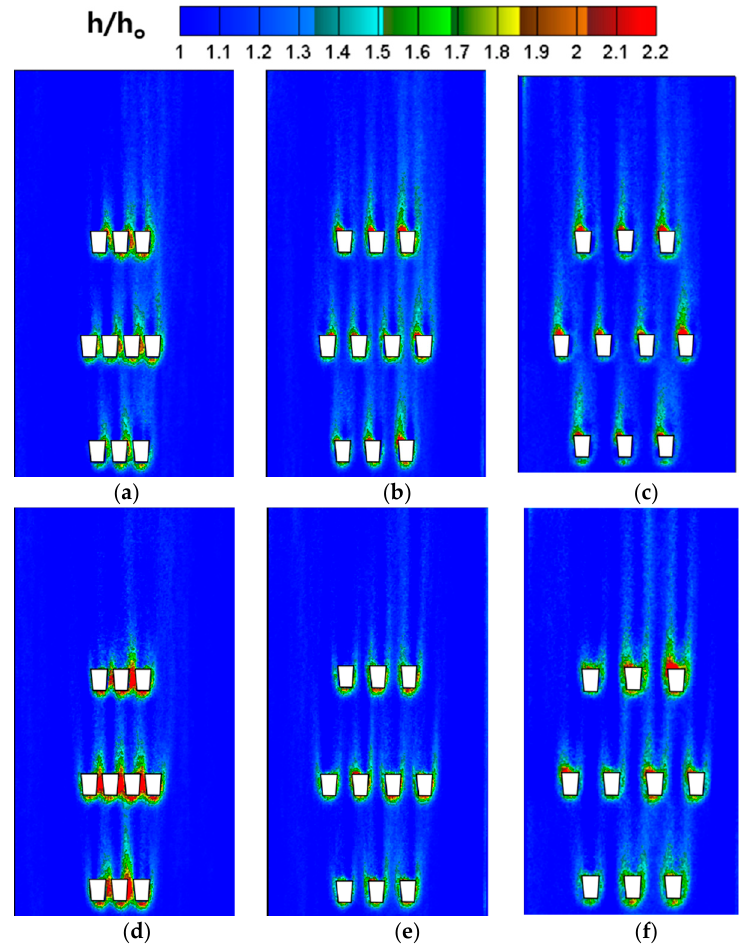
Figure 7. Distribution of h/h o for different hole pitch cases: ( a ) p/D = 5, M = 1.0; ( b ) p/D = 7.5, M = 1.0; ( c ) p/D = 10, M = 1.0; ( d ) p/D = 5, M = 2.0; ( e ) p/D = 7.5, M = 2.0; and ( f ) p/D = 10, M = 2.0.